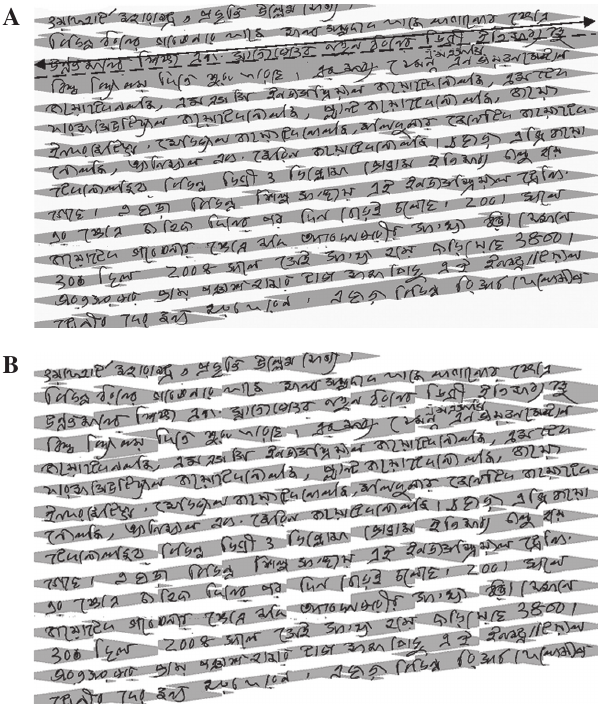
Figure 11. Comparison Between the Basic Water Flow Technique [1] and the Current Technique Shown on a Sample Bangla Document